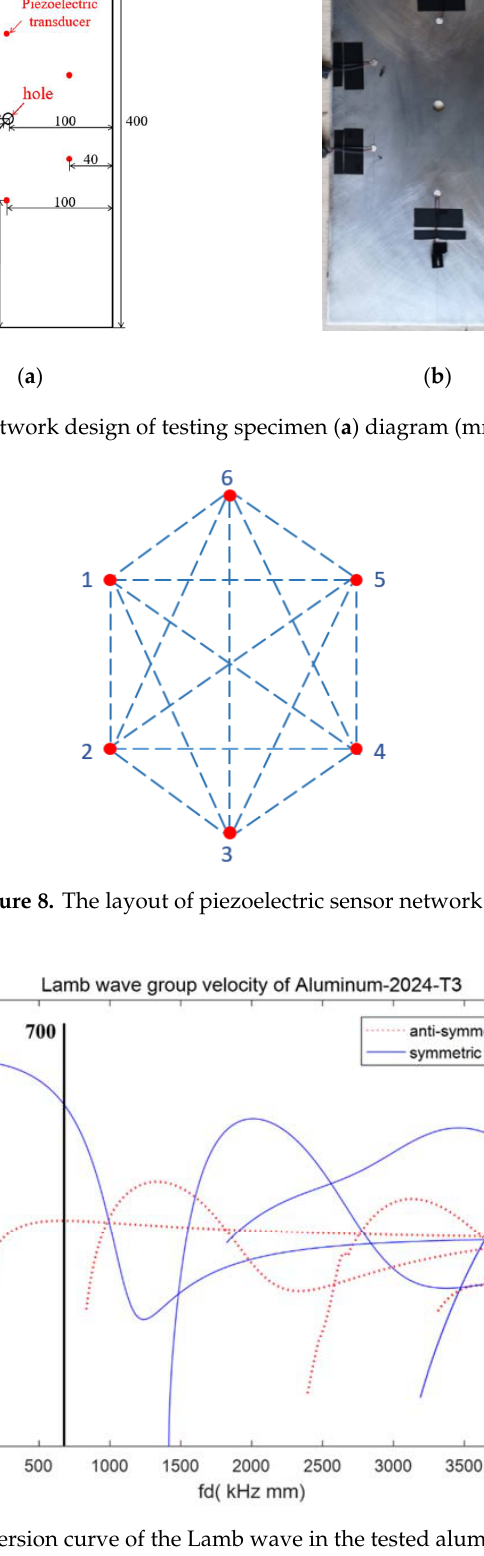
Figure 9. Dispersion curve of the Lamb wave in the tested aluminum plate.